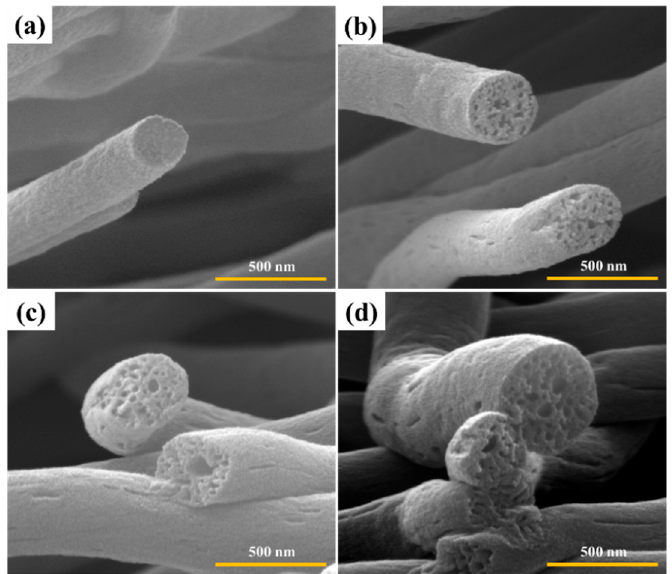
Figure 3. The cross-section SEM images of carbon nanofibers obtained with different ceramic pressure